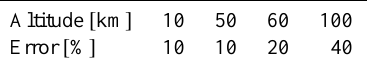
Table 5. Errors defined for the SABER data set. The error figures follow Huang et al.